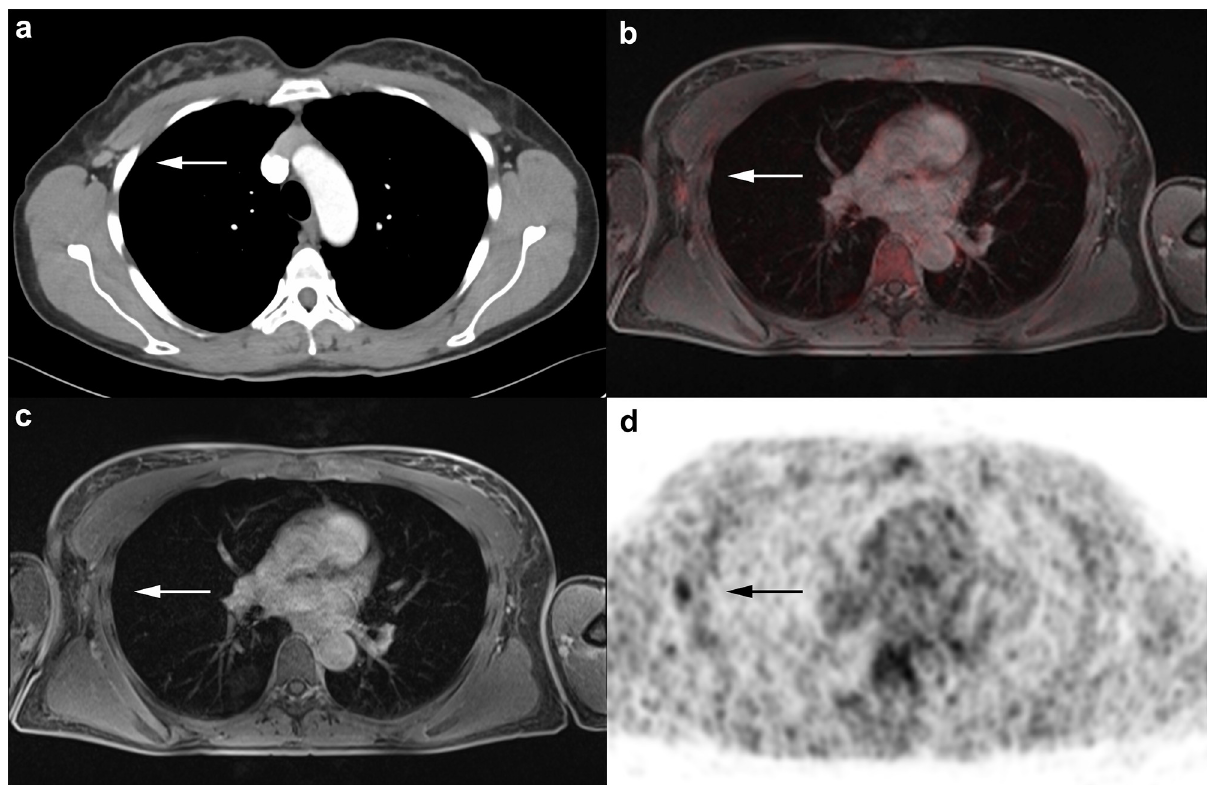
Fig 3. A 48-year old woman with diagnosis of primary breast cancer. Morphologically unsuspicious right axillary lymph node rated as not malignant in the CT scan ( a ). The 18 F-FDG PET/MRI shows a slight FDG uptake ( b-d ), indicating malignancy. Histopathology proved a tumor infestation.